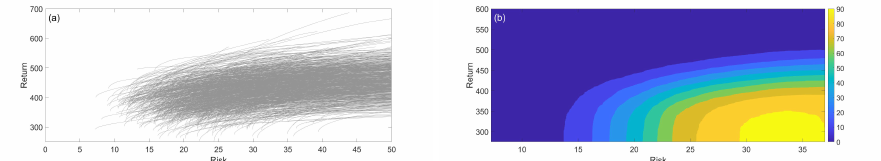
Figure 10. Probabilistic representation of efficient frontier; ( a ) random realization; ( b ) exceedance probability contour of efficient frontier